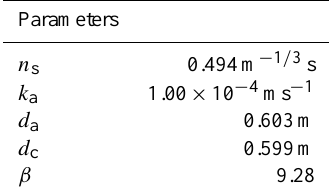
Table 1. The calibrated parameters of 1K-DHM.